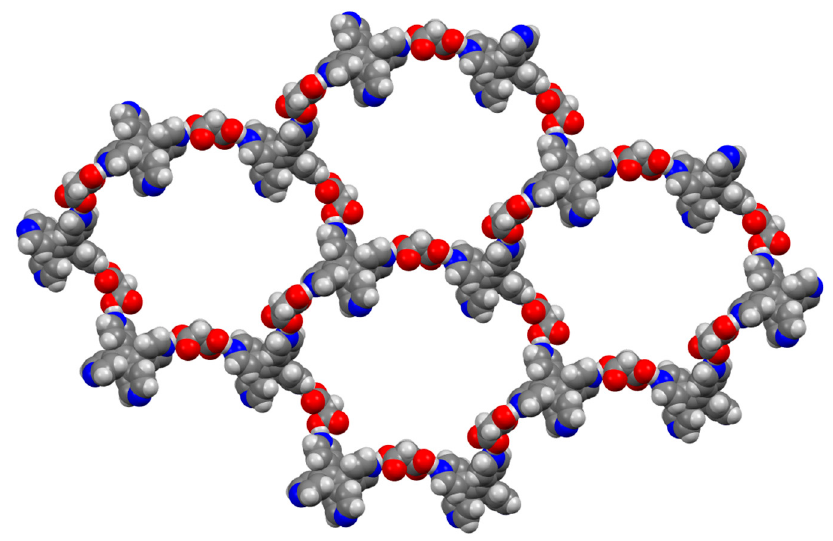
Figure 5. Spacefilling representation of a 2D (6,3) net formed from 3-connected tetra(pyridyl)ethylene nodes and malonic acid linkers.